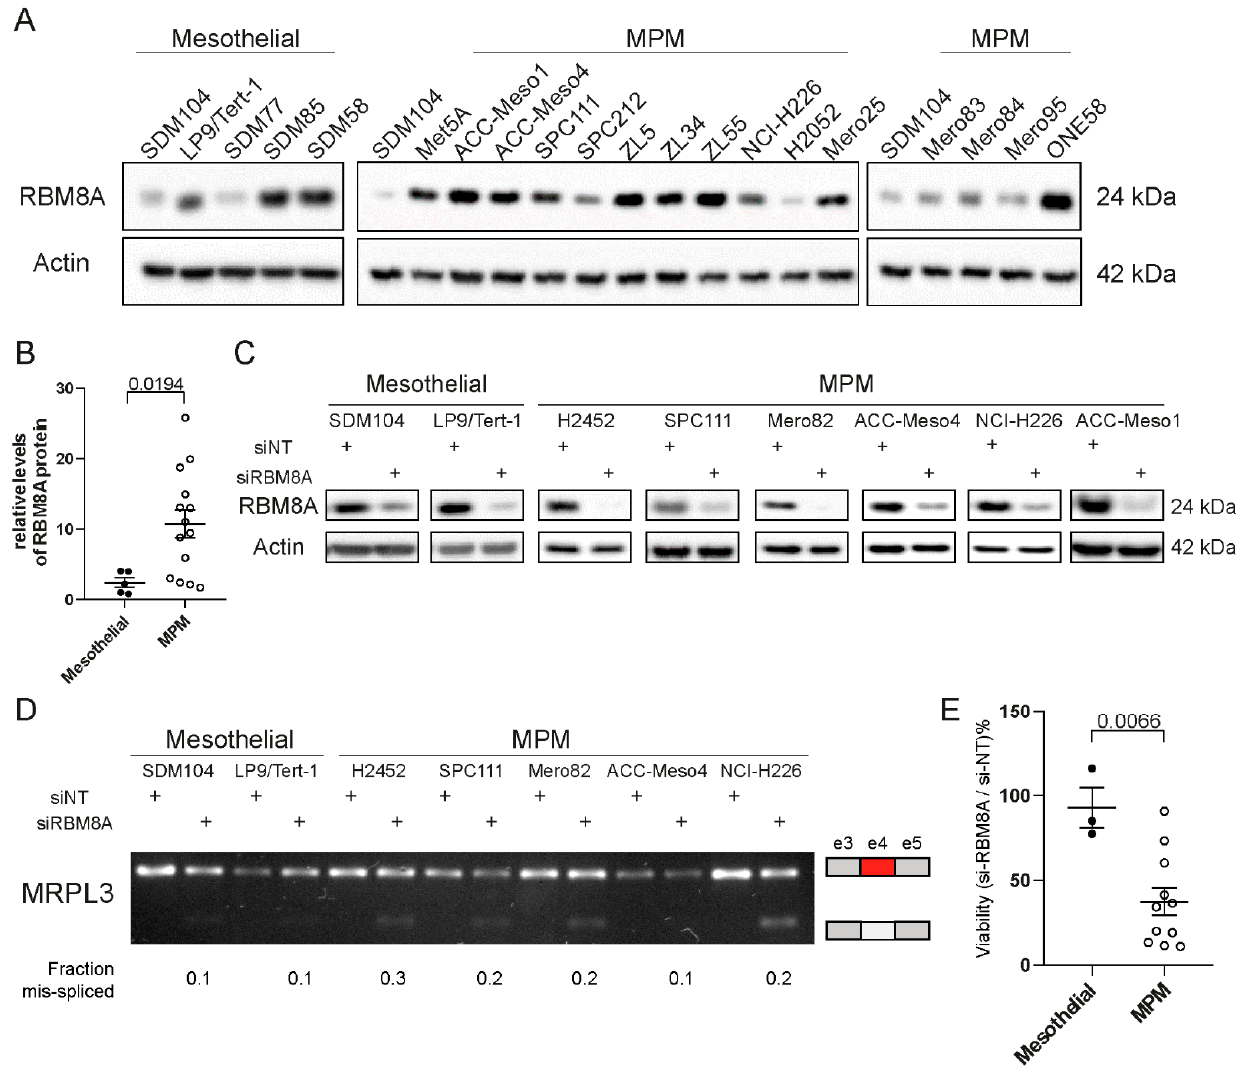
Figure 1. MPM cells express higher RBM8A protein levels and are more sensitive to its silencing compared to normal mesothelial cells. ( A ) Western blot analysis of RBM8A protein levels in mesothelioma cell lines (MPM) vs. mesothelial cultures (SDM104, LP9/TERT1, SDM77, SDM85, SDM58) and one immortalized mesothelial cell line (MET5A). Actin was used as a loading control. ( B ) Quantification of RBM8A protein expression in MPM vs. mesothelial cells. Data were normalized to expression in SDM104 cells. Mann–Whitney test. ( C ) Verification of RBM8A silencing by Western blot analysis in two mesothelial cell lines and six MPM cell lines. ( D ) RBM8A silencing is accompanied by defects in alternative splicing (exon 4 skipping in MRPL3). Quantification of the mis-spliced fraction upon RBM8A silencing was evaluated by densitometry. ( E ) Survival of MPM vs. mesothelial cells upon RBM8A silencing. Survival data are normalized to survival in non-targeting siRNA transfected cells (siNT). Unpaired t